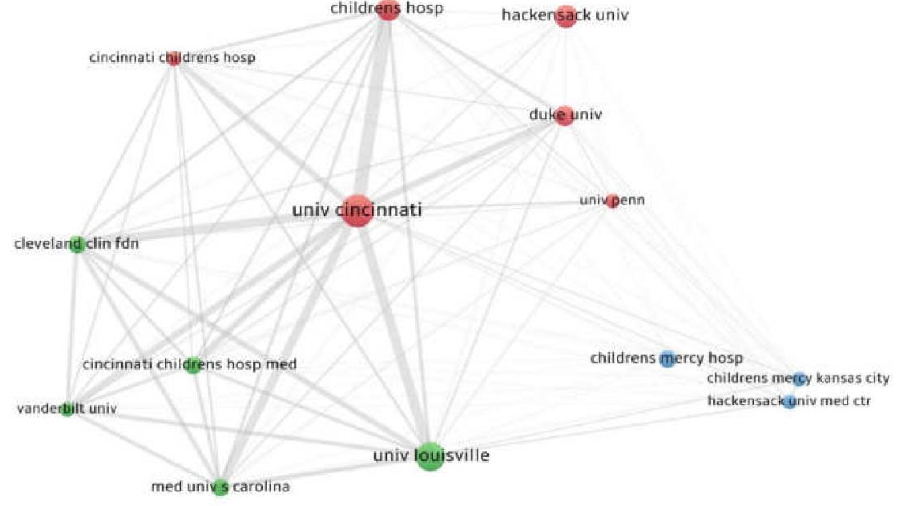
Figure 6. The most productive organizations and collaboration links .